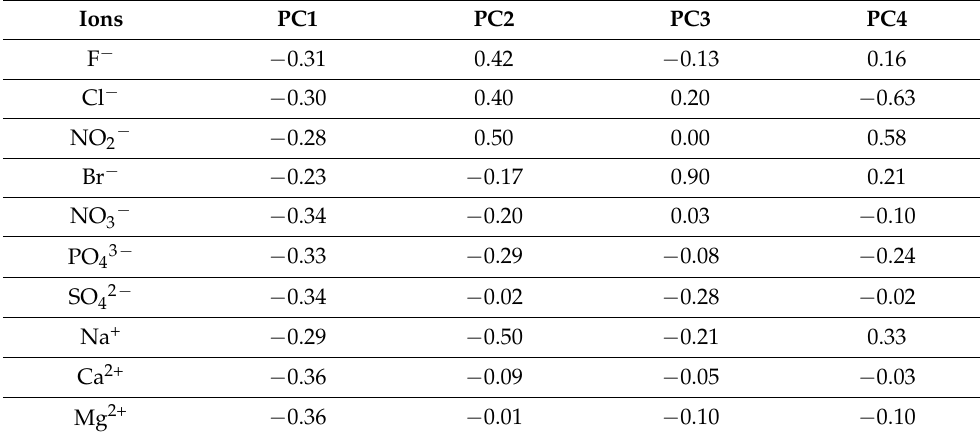
Table 5. Factor loadings of each ion specie on the identified four principal